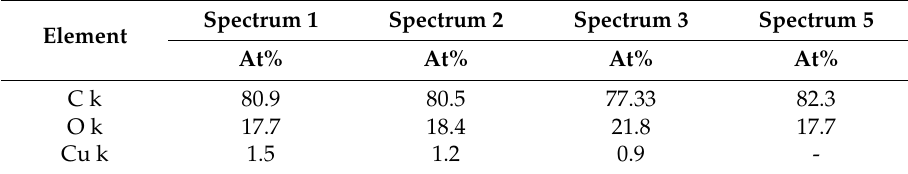
Table 4. Detected elements in the surface with Cu NWs at 5.1% w / w .